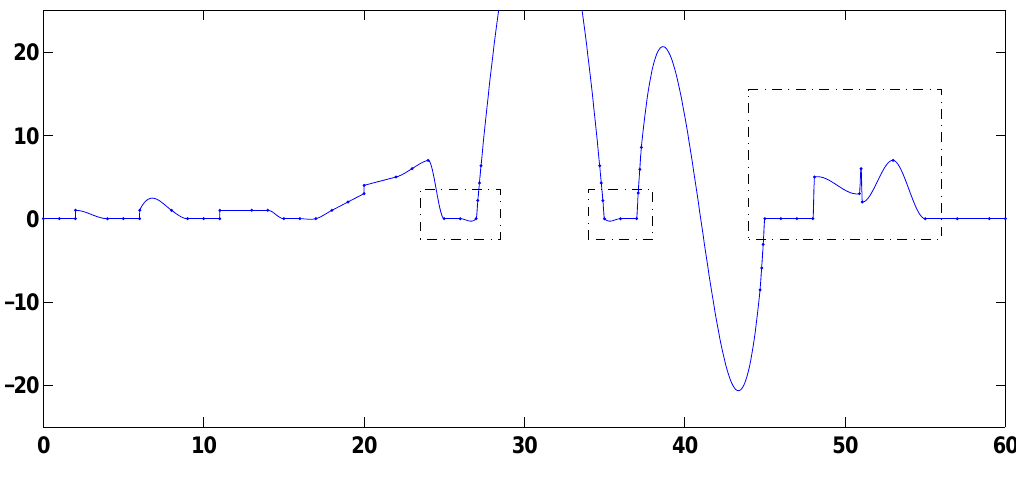
Figure 4 . Second-derivative-based global L